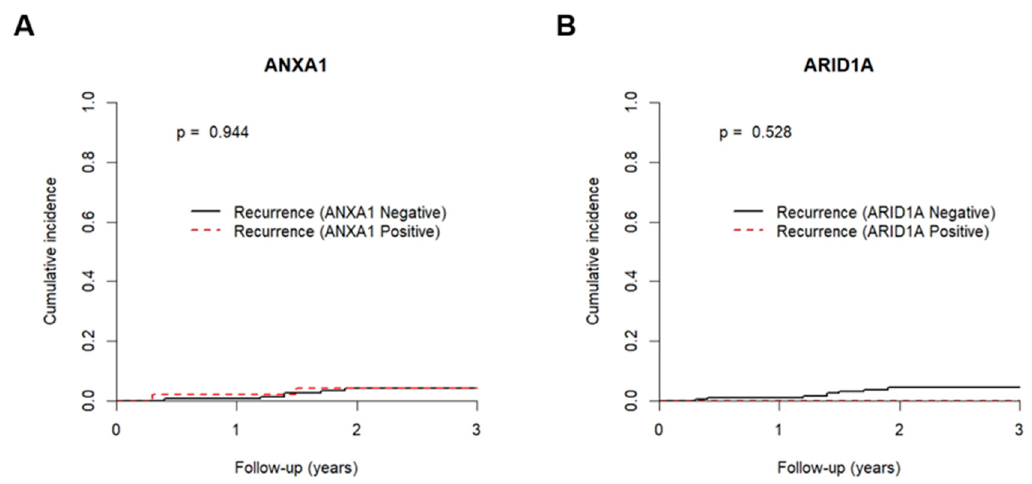
Figure 1. Cumulative incidence function plots according to ( A ) ANXA1 and ( B ) ARID1A immunoexpression. Dashed red line and full black line represent positive / high expression and negative / low expression for ANXA1 and ARID1A immunoexpression, respectively. p values obtained by Gray’s test for trastuzumab resistance